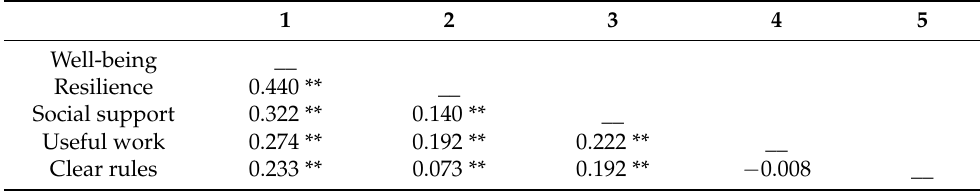
Table 3. Correlations between main variables (Pearson) ( N =